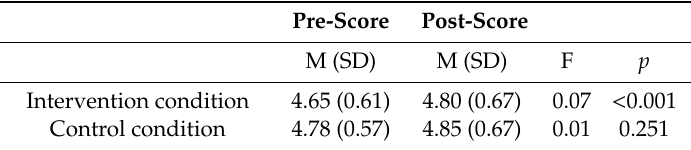
Table 2. Means and standard deviations of multiculturalism scores by time (pre- and post-), and F-statistics of the post-hoc